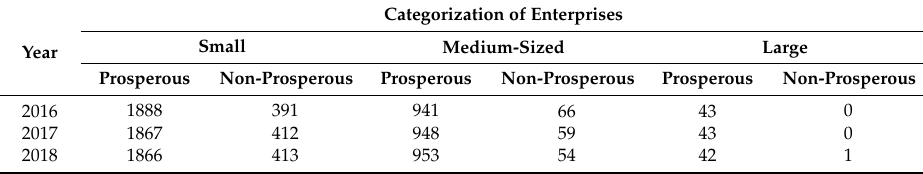
Table 4. Number of prosperous and non-prosperous enterprises in each